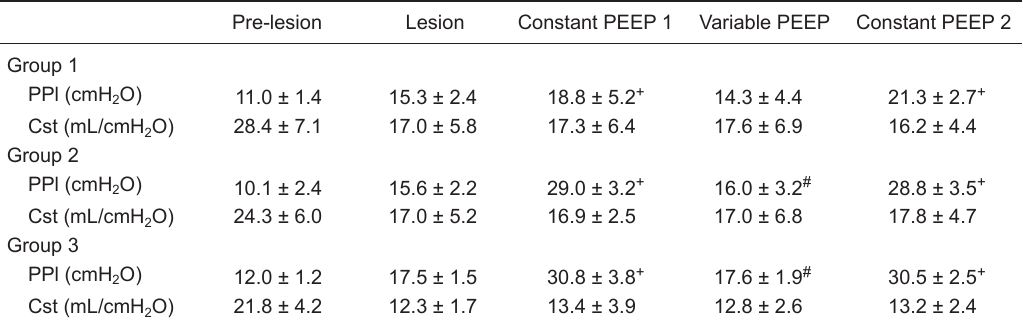
Table 3. Effect of intermittent PEEP on respiratory and hemodynamic parameters of dogs with acute respiratory distress syndrome.